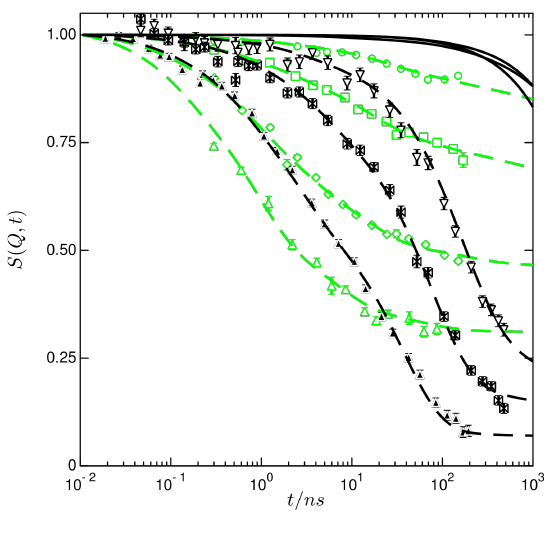
Figure 6. Same data and model (symbols and dashed lines) as in figure 5 but the computed curves (solid black lines) pertain to a slowed down matrix